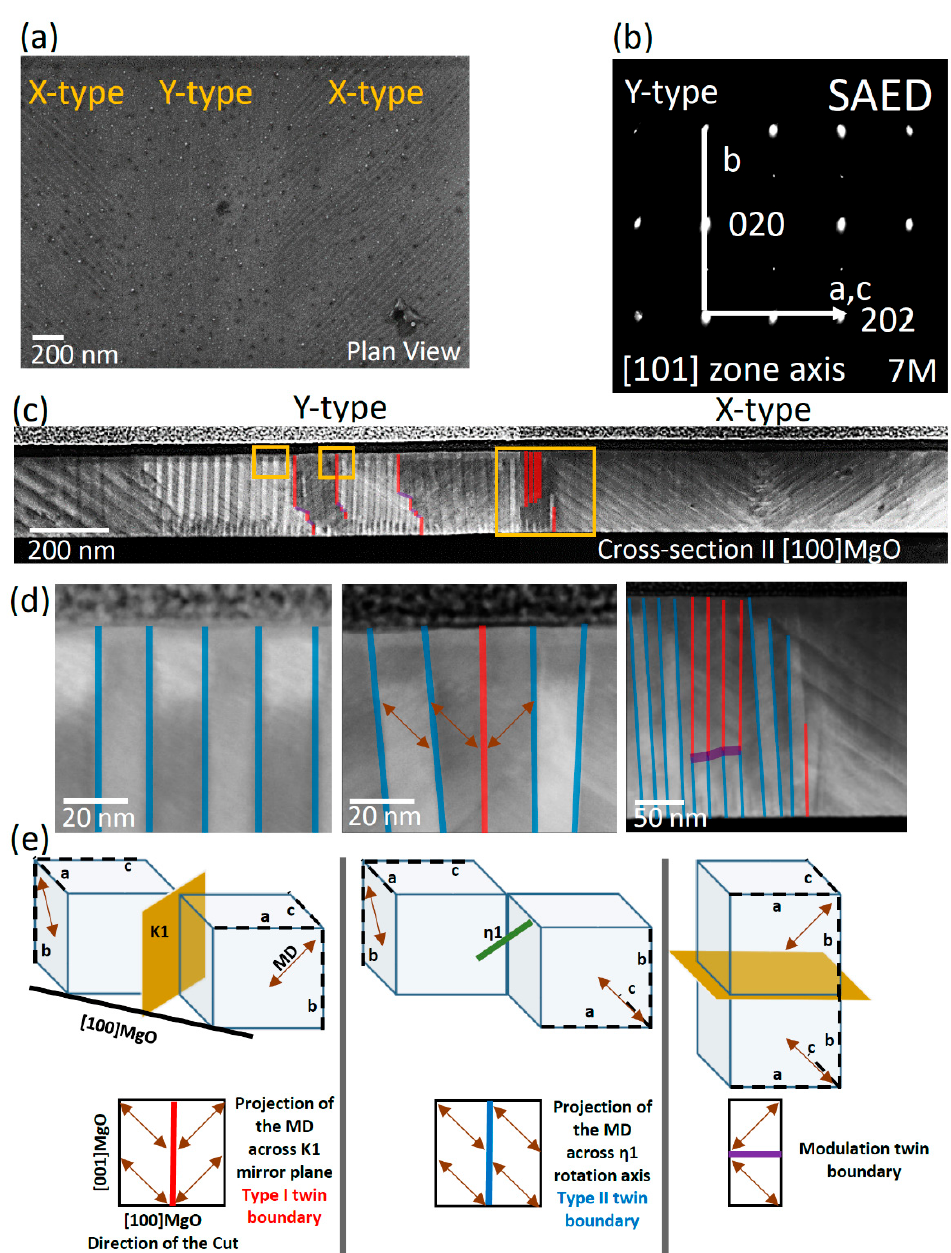
Figure 2. ( a ) SEM secondary electron image of sample #1 showing the coexistence of X - type and Y - type configurations; ( b ) selected-area electron diffraction (SAED) pattern of the Y - type region showing the parameters of the martensitic cell in the Y - type configuration, which have been fitted to 7M monoclinic cell and the orientation of each axis; ( c ) large - scale cross - section high-angle angular dark-field scanning transmission electron microscopy (HAADF) image of the sample; ( d ) magnified HAADF images of the marked areas in panel (b) showing the type of twins (red for type I, blue for type II and purple for modulation twin boundaries), the modulation directions are shown by double - headed arrows; ( e ) top: schematic representation of the martensitic cell axis and the modulation direction in Y - type across type I, type II and modulation boundaries (austenitic setting); bottom: the corresponding projection of the modulation direction in the plane of the lamella (FIB - cut along [100]MgO).